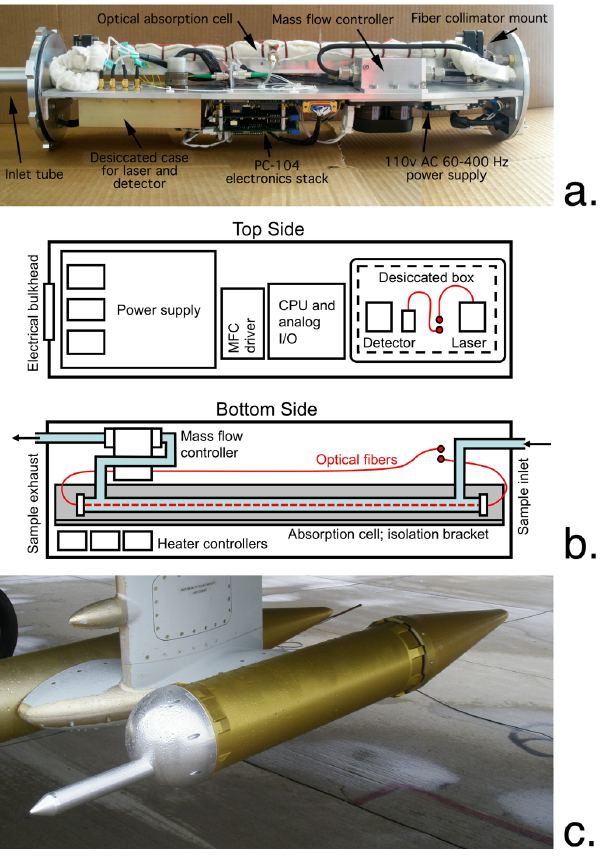
Fig. 1. Image (a) and schematic diagram (b) showing layout of pri- mary CLH-2 components on the top and bottom sides of a central structural plate, and image of the canister-mounted CLH-2 with in- tegral forward-facing inlet (c)